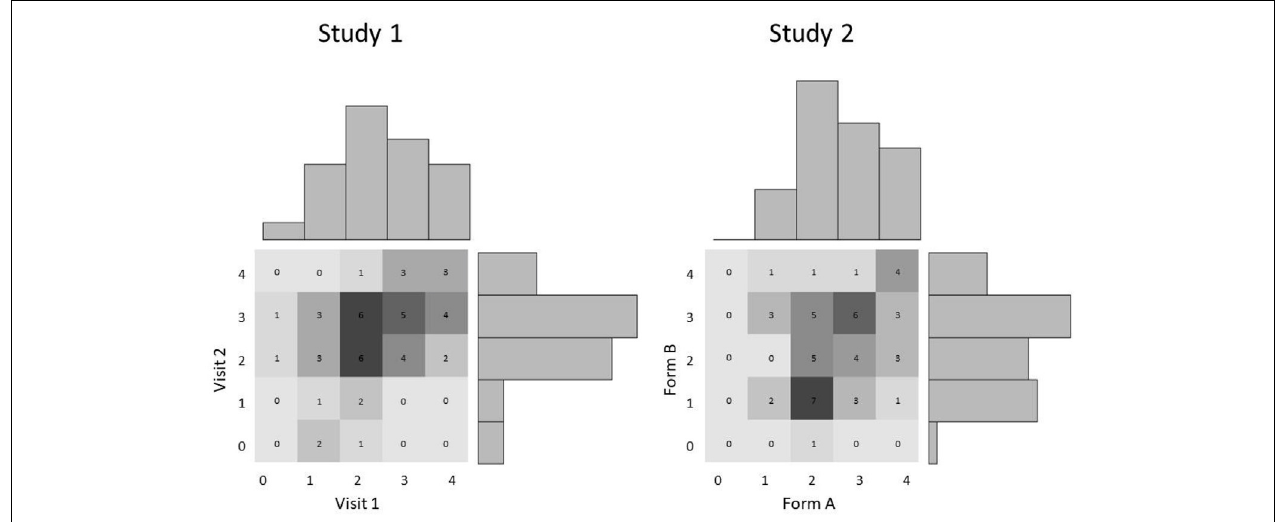
FIGURE 2 | Scores (out of 4) by visit/form, Study 1 ( left ) and Study 2 ( right ). Bar graphs indicate marginal frequencies of scores on each visit/form. Numbers in the squares indicate the number of children having obtained each possible combination of scores; darker shades indicate higher